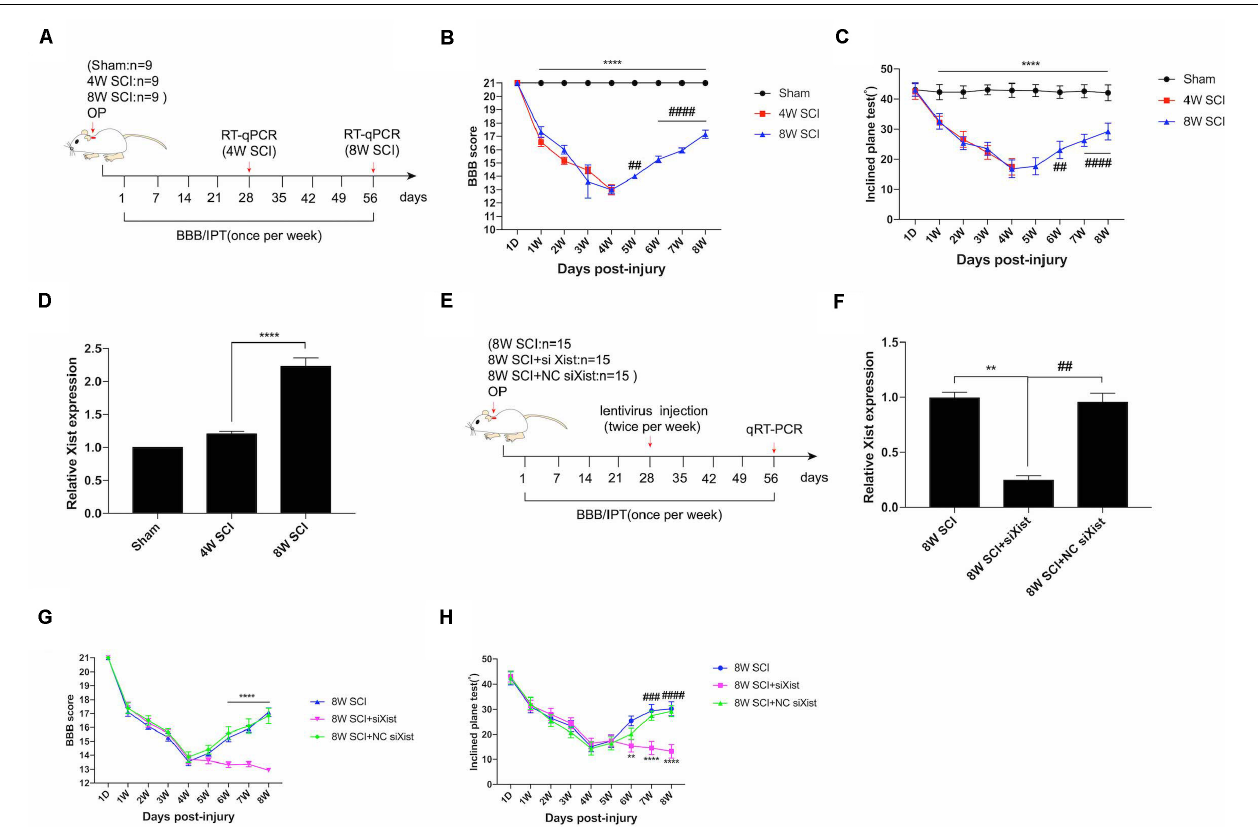
FIGURE 1 | Xist is upregulated during endogenous neurological repair after CCSCI. (A) Experimental design. (B) Animals were tested weekly starting from 1 dpi in an open field, and the endogenous neurological repair was evaluated according to the Basso, Beattie, and Bresnahan (BBB) score. **** p < 0.0001: the 8W SCI group vs. the sham group; ## p < 0.01, #### p < 0.0001: the 8W SCI group vs. the 4W SCI group. (C) Animals were tested weekly starting from 1 dpi using the inclined plane test (IPT), and the angle ( ◦ ) was recorded to reveal endogenous neurological repair. **** p < 0.0001: the 8W SCI group vs. the sham group; ## p < 0.01, #### p < 0.0001: the 8W SCI group vs. the 4W SCI group. (D) Relative Xist expression in the cervical spinal cord was determined by RT-qPCR in the sham, 4W SCI, and 8W SCI groups. **** p < 0.0001: the 8W SCI group vs. the 4W SCI group. (E) Experimental design to explore the role of Xist in endogenous neurological repair. (F) Relative Xist expression in the cervical spinal cord was determined by RT-qPCR in the 8W SCI, 8W SCI + siXist, and 8W SCI + NC siXist groups. ** p < 0.01: the 8W SCI group vs. the 8W SCI + siXist group; ## p < 0.01: the 8W SCI + siXist group vs. the 8W SCI + NC siXist group. (G) The endogenous neurological repair was evaluated using the BBB score. **** p < 0.0001: the 8W SCI + siXist group vs. the 8W SCI + NC siXist group. (H) The endogenous neurological repair was scored using the IPT. ** p < 0.01, **** p < 0.0001: the 8W SCI + siXist group vs. the 8W SCI group; ### p < 0.001, #### p < 0.0001: the 8W SCI + siXist group vs. the 8W SCI + NC siXist group. Data are expressed as the mean ±